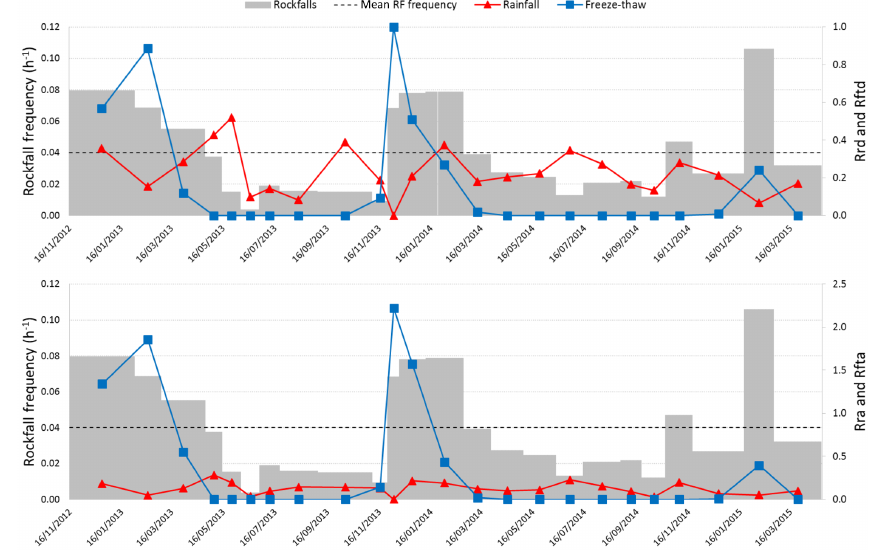
Figure 7. Rockfall frequency for the different observation periods, with rainfall and freeze–thaw duration ratios (up) or rainfall and freeze– thaw amount ratios